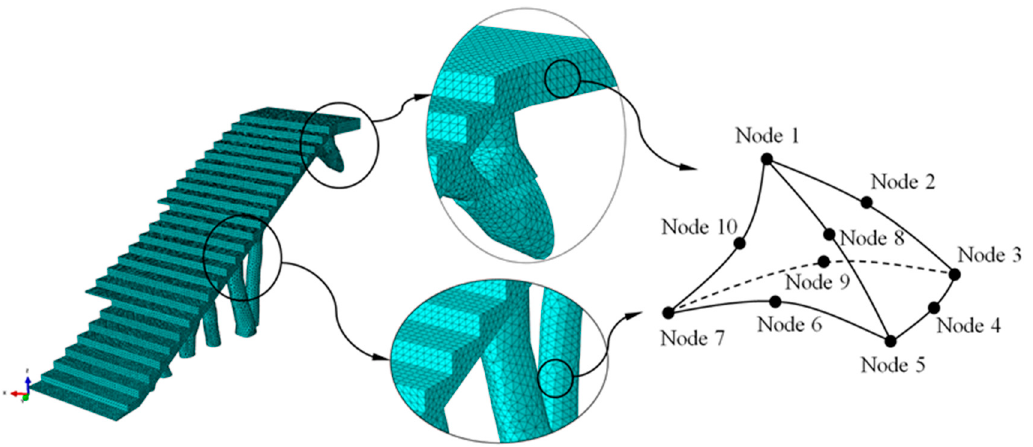
Figure 23. Mesh generated for the mechanical simulation, the BIM building element E 1 .